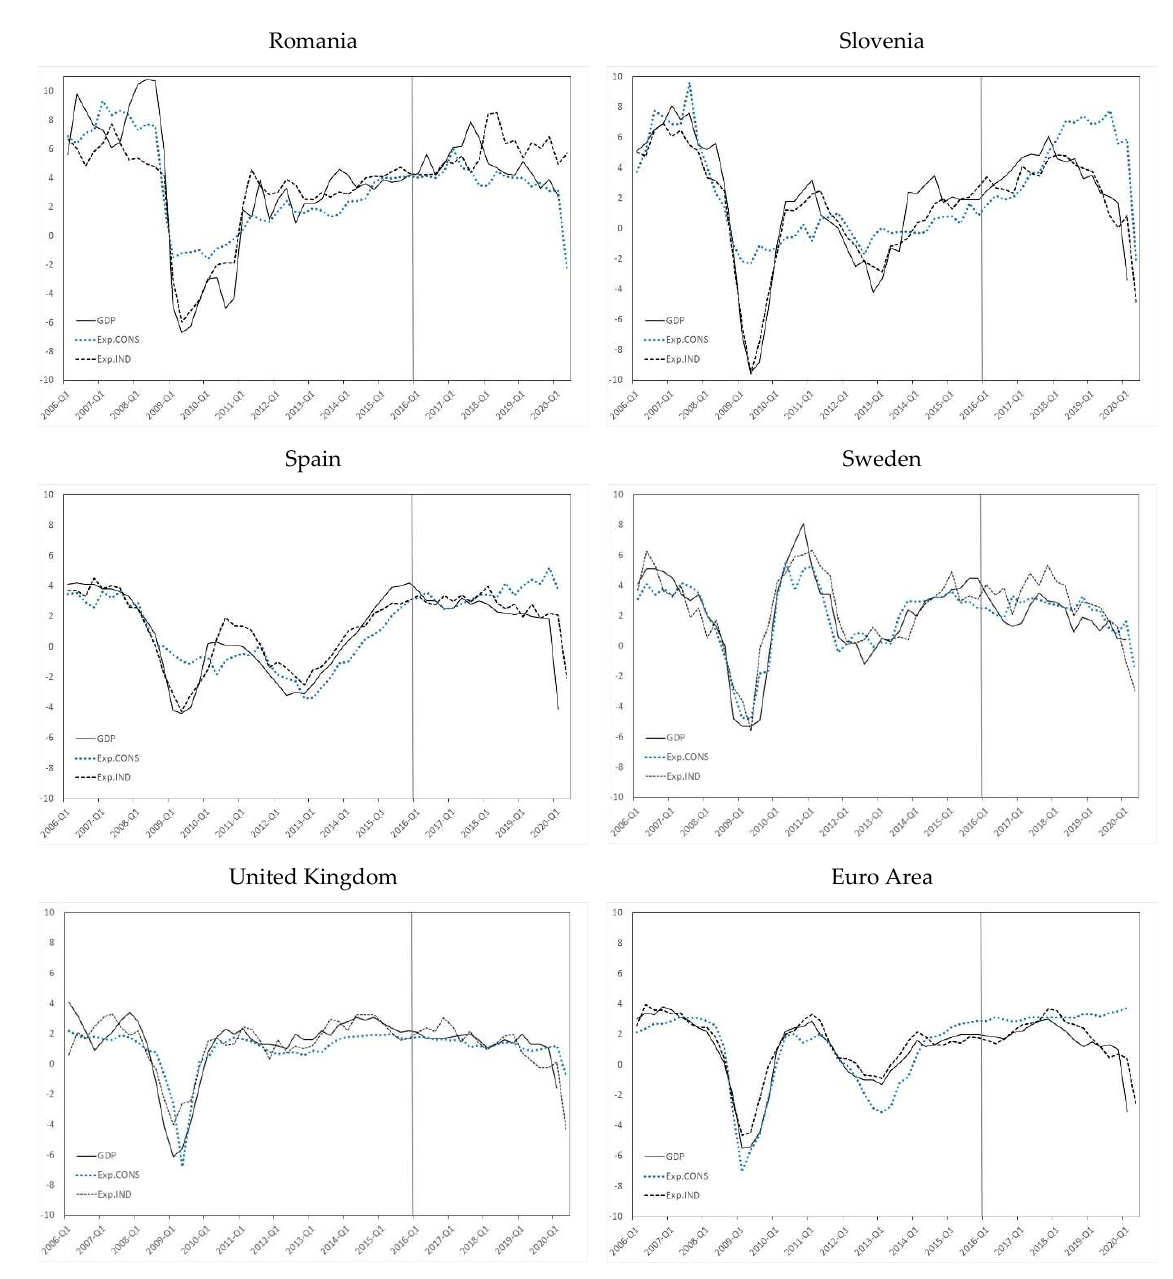
Figure 2. GDP and firms’ and consumers’ evolved confidence indicators. Notes: the black line represents the evolution of GDP growth, the grey dotted line the evolution of consumer confidence (Exp.CONS), and the dashed black line the evolution of industrial confidence (Exp.IND). The vertical line in 2016.Q1 marks the beginning of the out-of-sample period.